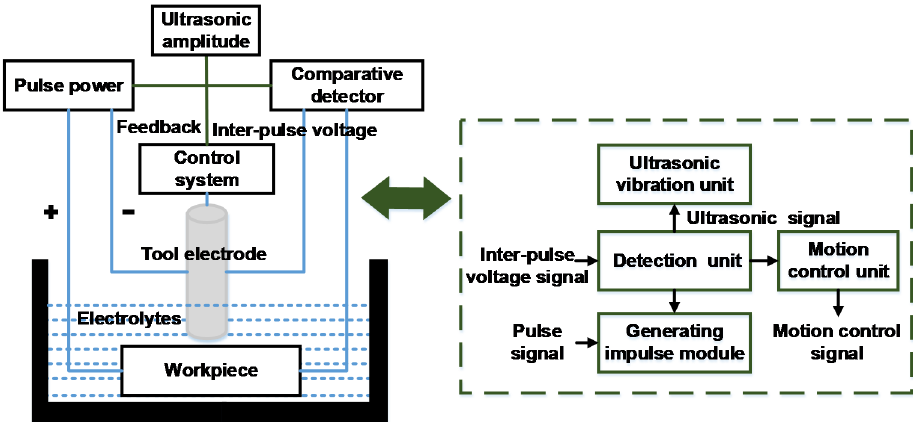
Figure 6. Schematic diagram of inter-pulse detection and control system.